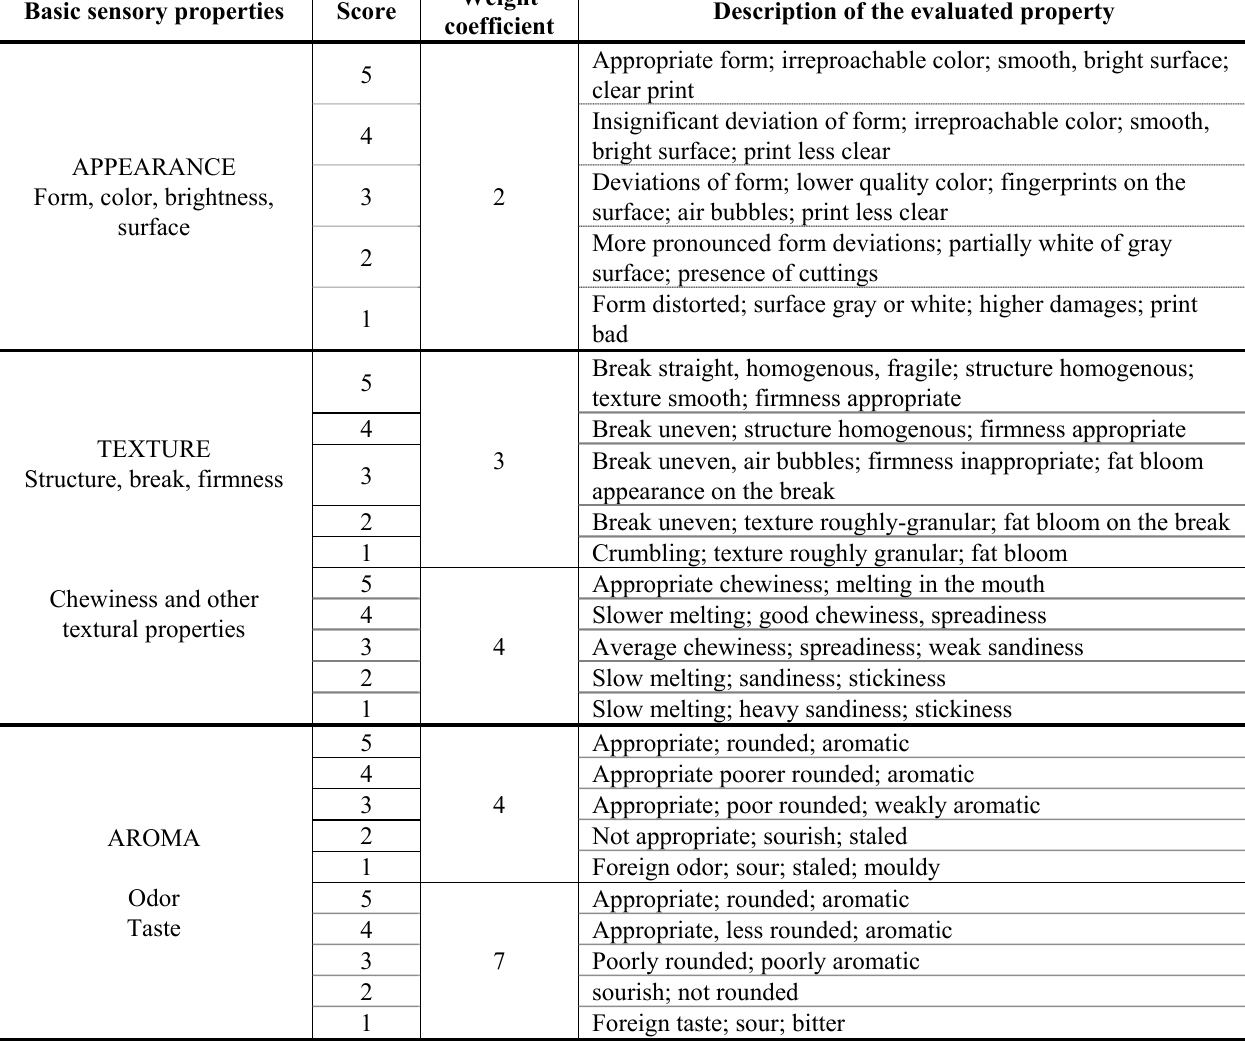
Table 1 . Sensory evaluation of the chocolate quality using the scoring procedure Basic sensory